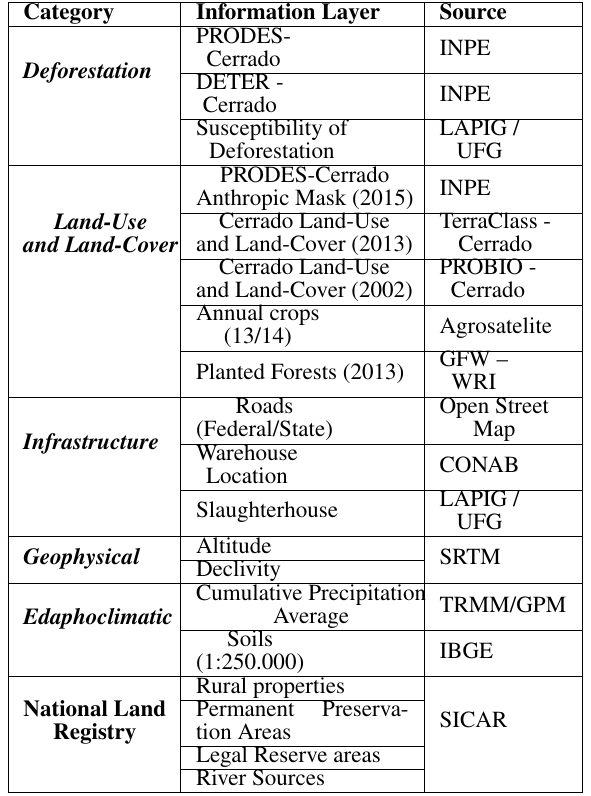
Table 1. Full overview of the datasets imported into DPAT.